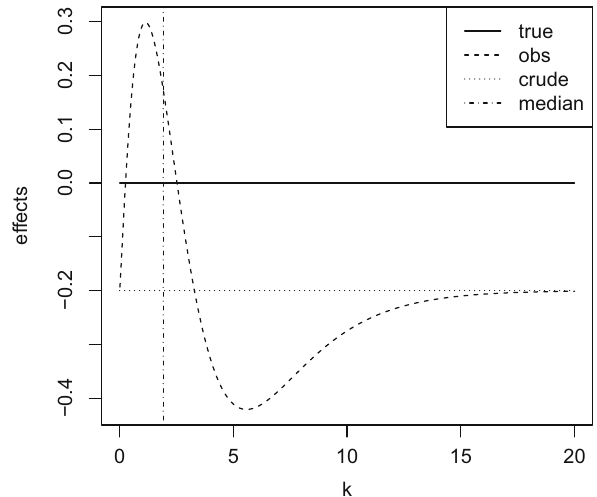
Figure 6: True, observed, and crude e ff ects as functions of the cuto ff k in Setting